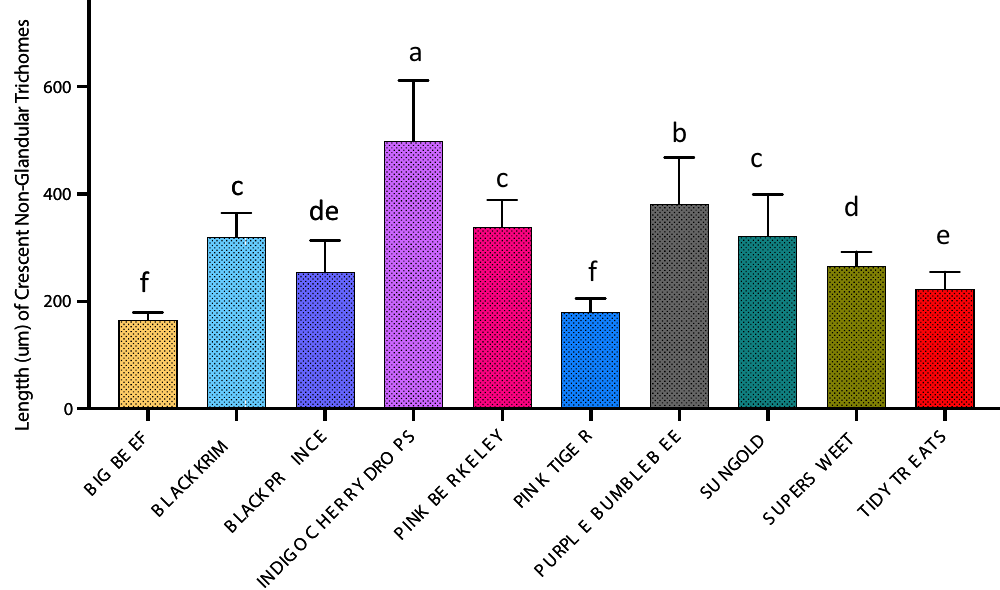
Fig. 11 Comparison of length (µm) of most common non-glandular trichome (crescent non-glandular with multicellular jointed stalk) in ten varieties of